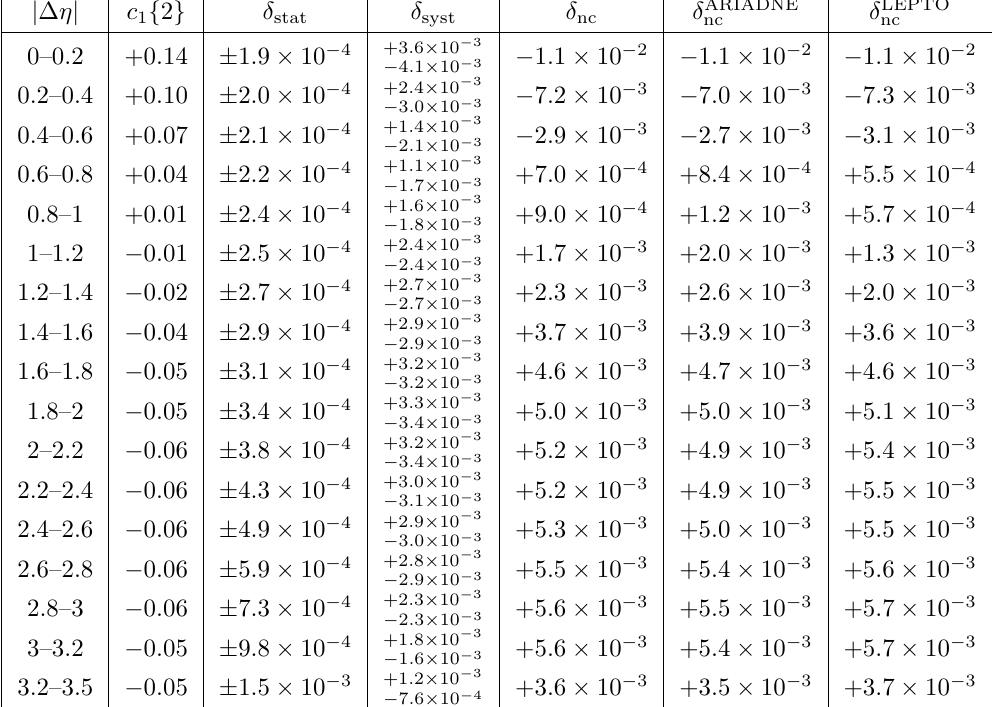
Table 13 . c 1 f 2 g versus j (cid:1) (cid:17) j from (cid:12)gure 8 (a) and (cid:12)gure 11 (a), p T > 0 : 1 GeV; (cid:14) stat , (cid:14) syst and (cid:14) nc denote the statistical, systematic and Monte Carlo non-closure uncertainties,